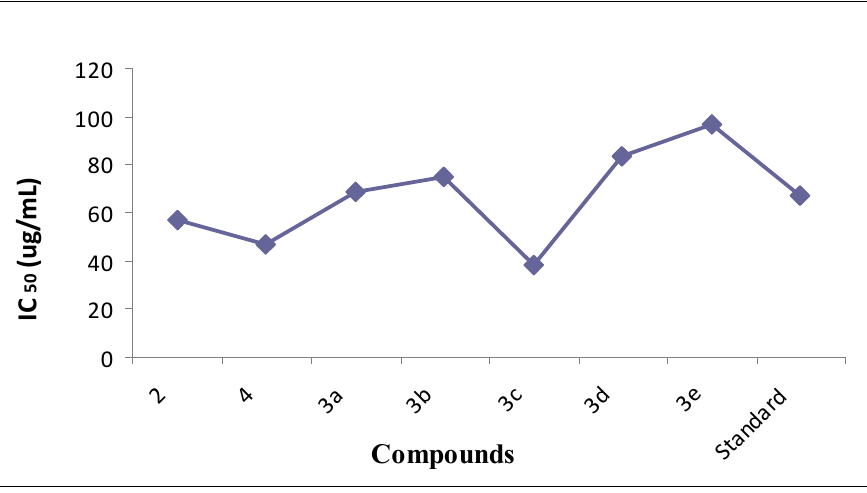
Figure 4. Nitric oxide scavenging activity IC